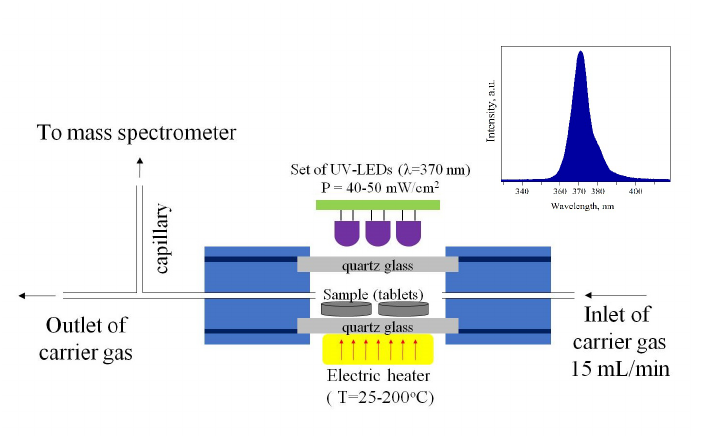
Figure 3. The design of the cell used for photostimulated MS experiments. The inset shows the emission spectrum of the LEDs used for irradiation.